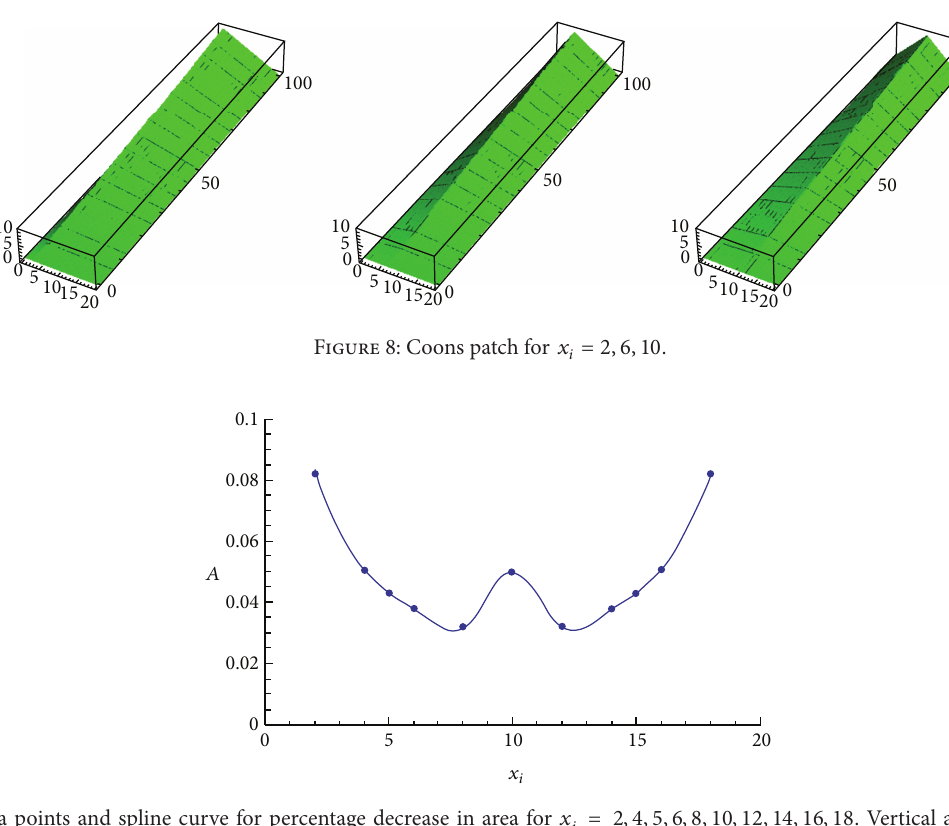
Figure 9: Data points and spline curve for percentage decrease in area for 𝑥 𝑖 = 2, 4,5, 6, 8, 10,12, 14, 16, 18 . Vertical axis 𝐴 denotes the percentage decrease in